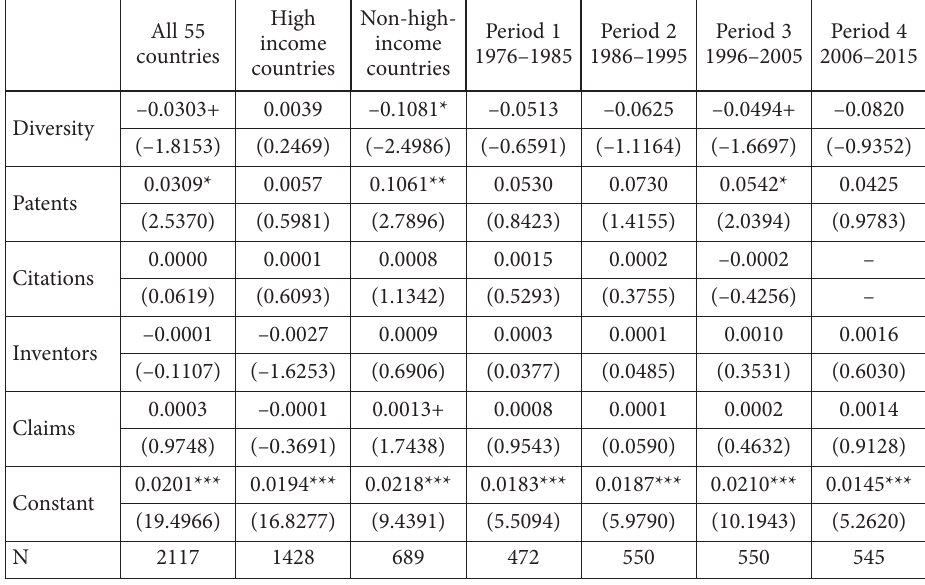
Table 5. Results of the 2 nd stage of 2SLS